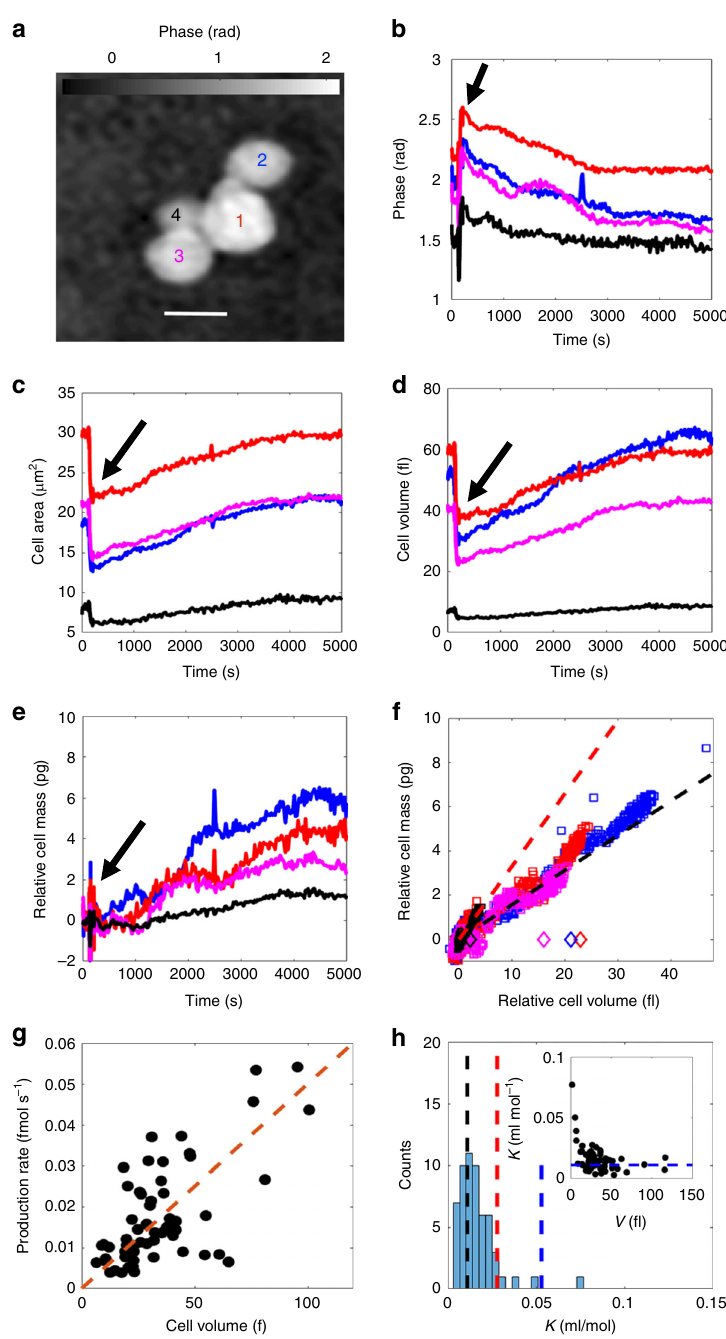
Fig. 3 Characterization of cells under osmotic adaptation. a – c Monitored phase shifts ( ^ ϕ ) ( b ) and projected cell areas ( c ) of the four cells shown in a during osmoadaptation (black arrow indicates time point of osmotic upshift). The line colors correspond to the cell numbers in a . Scale bar in a is 5 μ m. d , e Inferred cell volume V cell ( t ) ( d ) and the relative cell mass m dry ( t ) − m 0 ( e ), where m 0 denotes the cell mass prior to osmotic upshift. f Relative cell mass m dry ( t ) − m 0 as a function of relative cell volume V cell ( t ) − V m , where V m denotes the minimum cell volume attained after initial water out fl ux, at different stages in the osmoadaptation for the cells shown in a . The initial relative cell masses and relative volumes are shown as open diamonds. Immediately upon exposure to a high osmolarity medium, the cells expel water and reduce in volume while retaining their mass, shifting horizontally in the fi gure. Thereafter the cells slowly expand while gaining in mass (colored squares). The black dashed line represents the expected cell mass increase for accumulation of glycerol. The red dashed line represents the expected mass increase with volume had the cell swelling been a result of metabolic cell growth. g The rate of osmolyte production increases will cell size ( V m ) with a typical production rate of 0.5 mM s − 1 (red dashed line). h The estimated value of the parameter K de fi ned in the main text for N = 57 cells is consistent with accumulation of primarily glycerol ( K = 0.011 ml mol − 1 shown as dashed black line). Also shown are the expected values of K for glucose ( K = 0.028 ml mol − 1 shown as red dashed line) and trehalose ( K = 0.053 ml mol − 1 shown as blue dashed line) Inset: Small cells appear to accumulate compounds with slightly larger values of K . The blue dashed line corresponds to the value of K for glycerol. The cell volume is here taken to mean the minimum cell volume after osmotic upshift ( V m